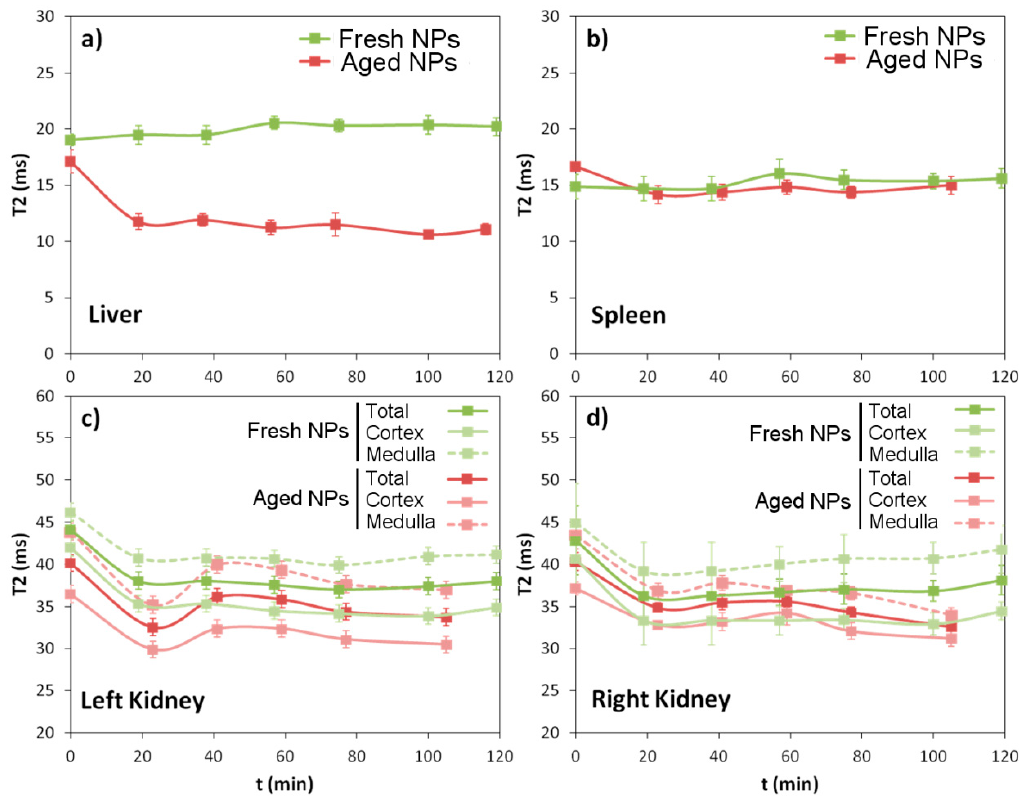
Figure 6. Evolution of the T2 relaxation times with time for the four different organs analyzed (liver ( a ), spleen ( b ), left kidney ( c ), and right kidney ( d )), after the injection of the aged solution, (red) and a freshly prepared solution, (green) of IONPs in two representative animals of each group.